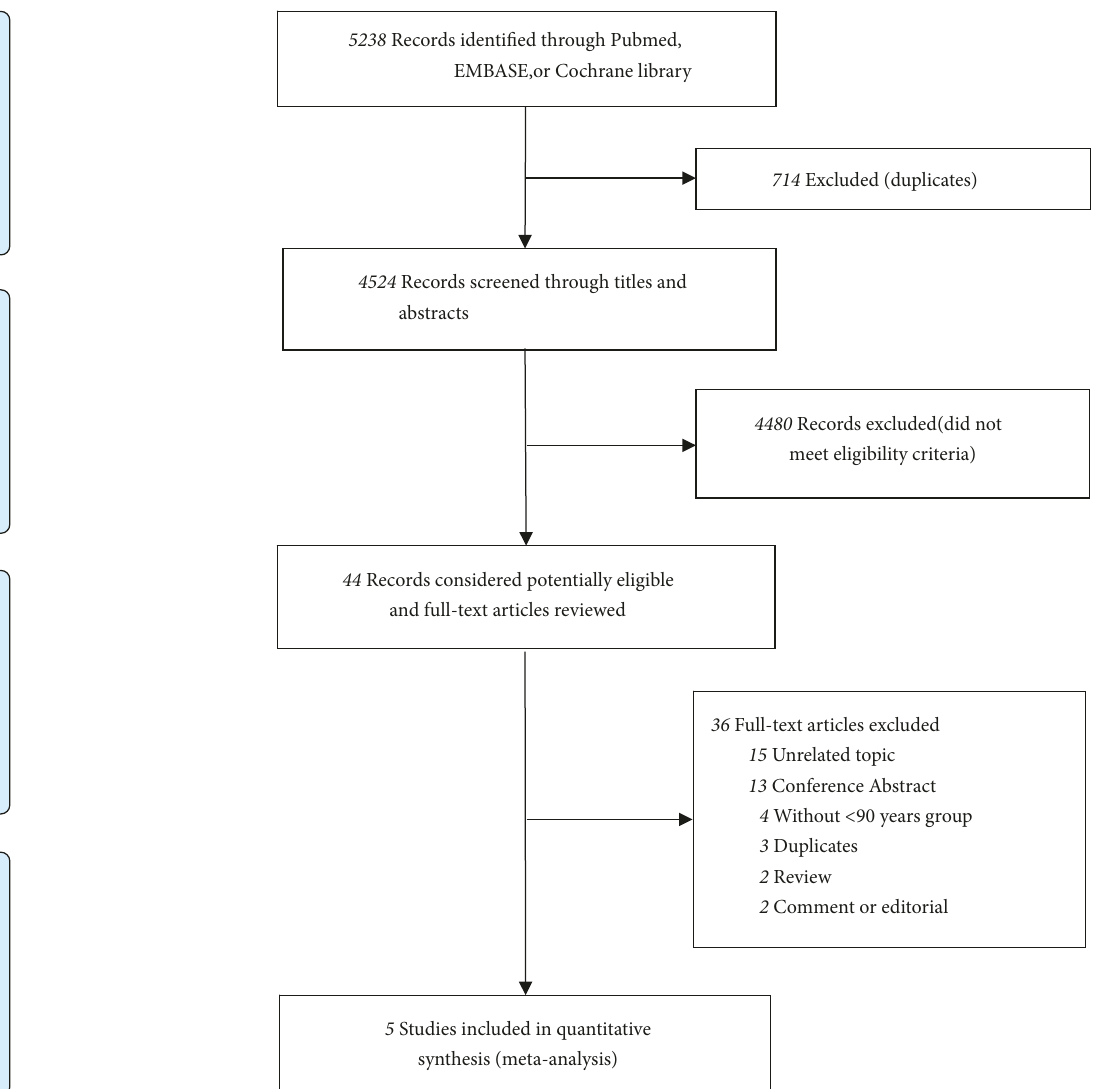
Figure 1: Flow diagram of study selection process.